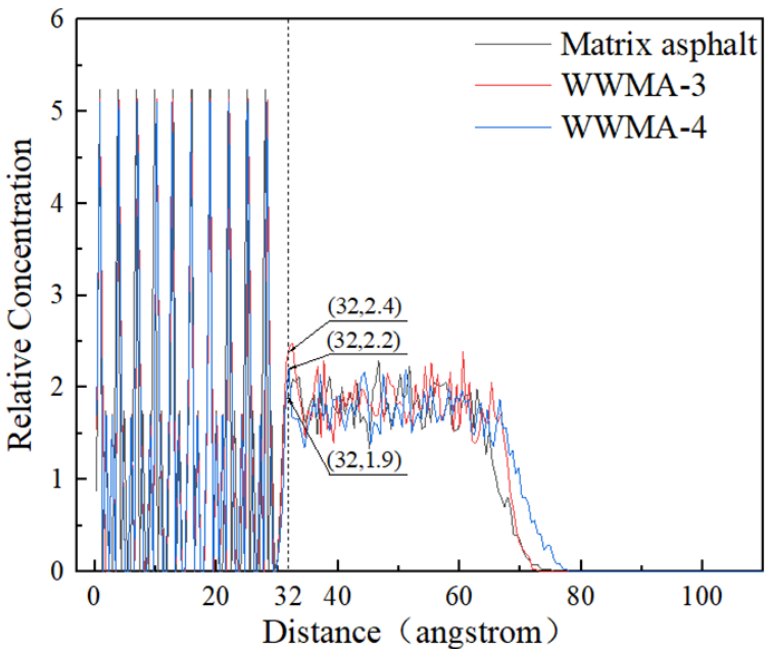
Figure 12. The relative concentration distribution of matrix asphalt, WWMA-3, WWMA-4, and CaCO 3 .